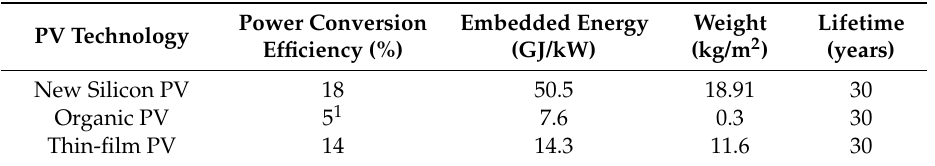
Table 3. Technical input values to assess global environmental impact of photovoltaic installations for improving livelihoods.